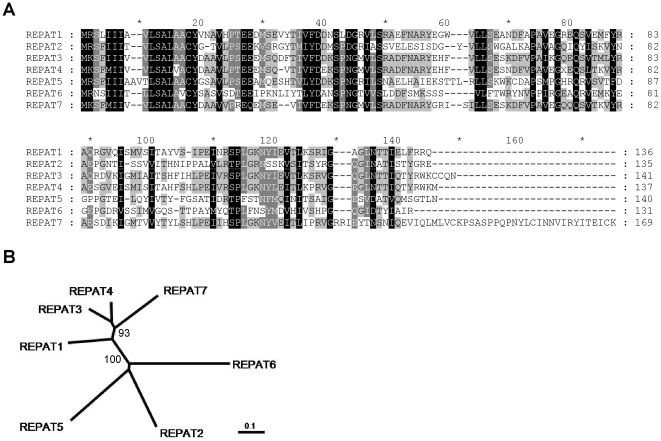
Sequence comparison of novel REPAT proteins.A) ClustalW alignment of the deduced amino acid sequences from novel REPAT proteins. (B) Phylogenetic tree derived from the ClustalW alignment by the neighbor-joining method. To clarify the figure, bootstrap values are shown only for the two main branches.